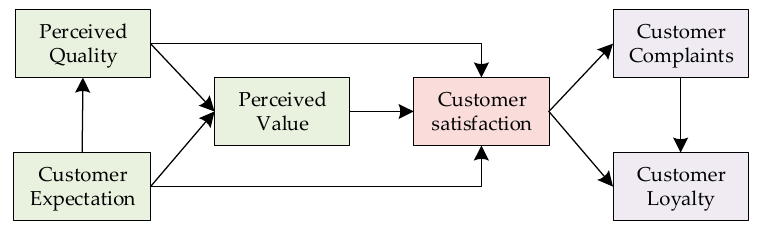
Figure 3. Tourist satisfaction model [18] .